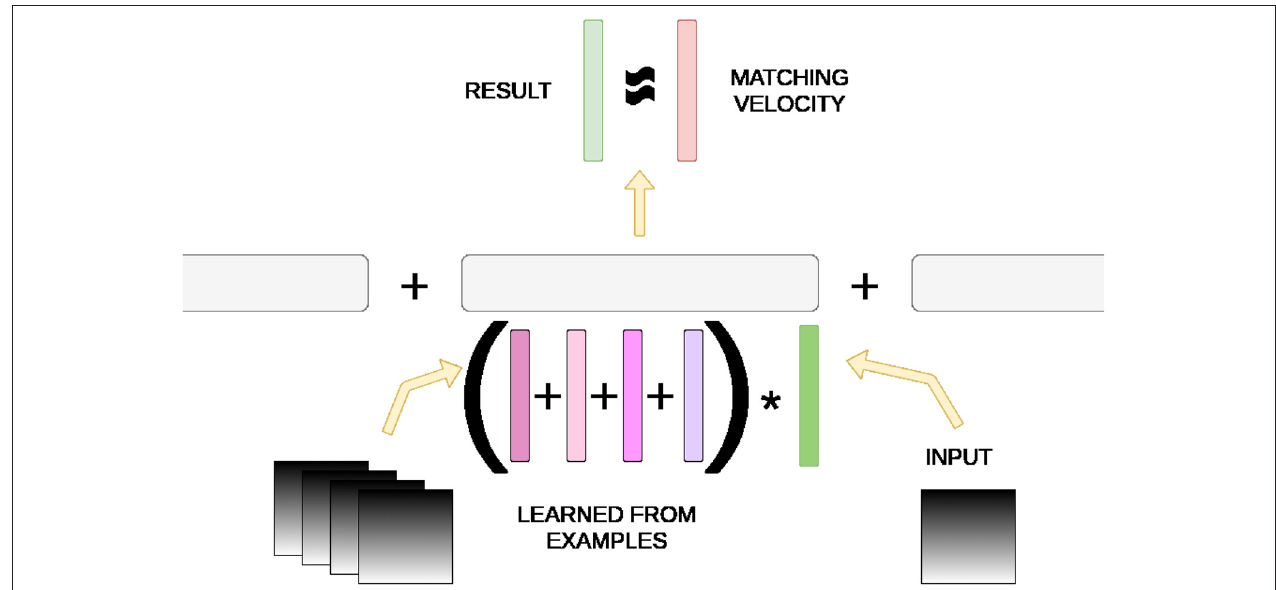
FIGURE 2 | Hyperdimensional memory mechanism in HAP (Mitrokhin et al., 2019). A memory unit m consists of velocity bins as fields that are bound to another record of summed vector representations of time image slices from training. An input image is converted to its hyperdimensional vector representation and XOR’d with m . If it matches approximately with one of the image slice sums, the result contains the matching velocity representation with some